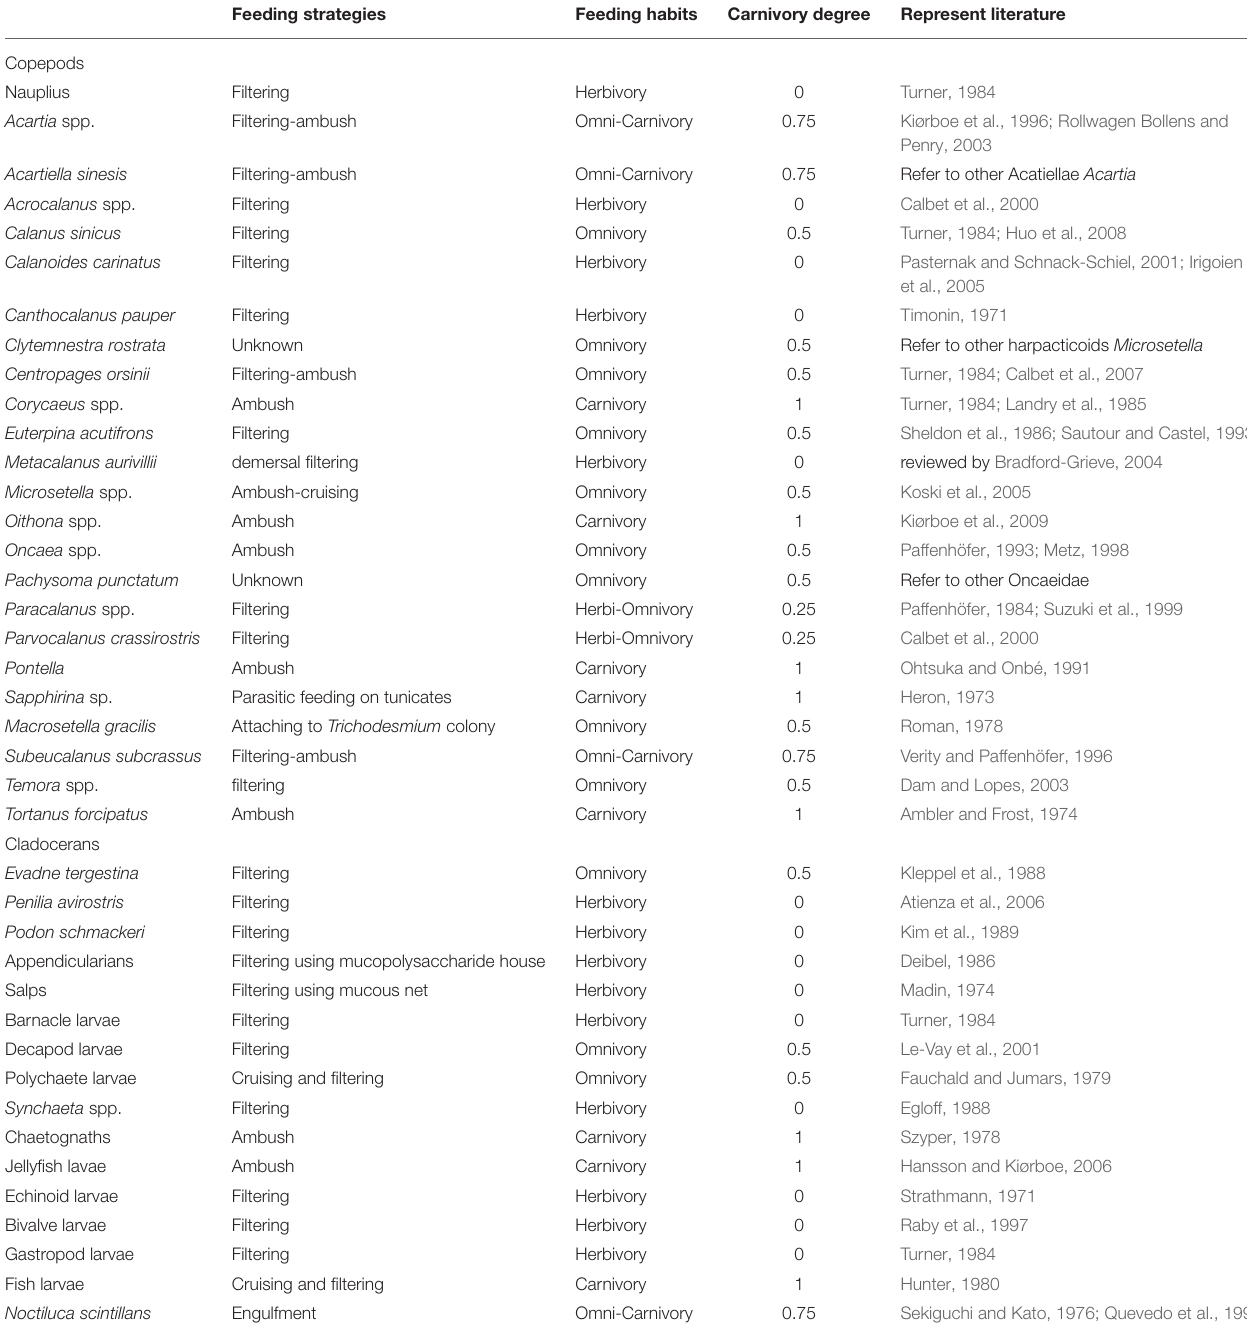
TABLE 1 | Carnivory degree of mesozooplankton species in Hong Kong coastal and estuarine